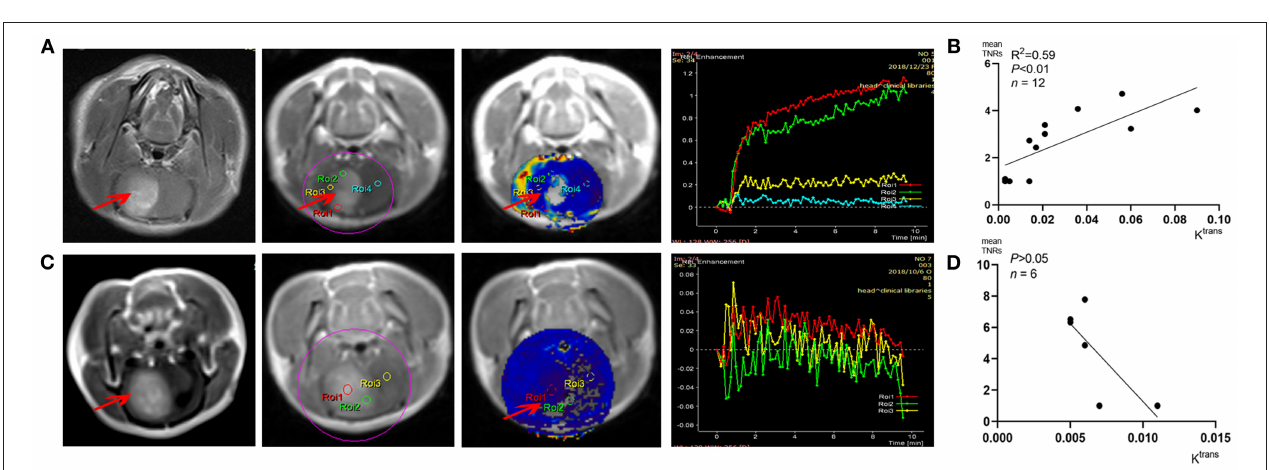
FIGURE 6 | (A,C) Representative DCE-MRI analysis results and corresponding K trans maps. (B,D) Correlation analysis results between K trans values and corresponding tumor S- [ 18 F]CF 3 -D-CYS uptakes (represented by mean TNRs) (right arrows: